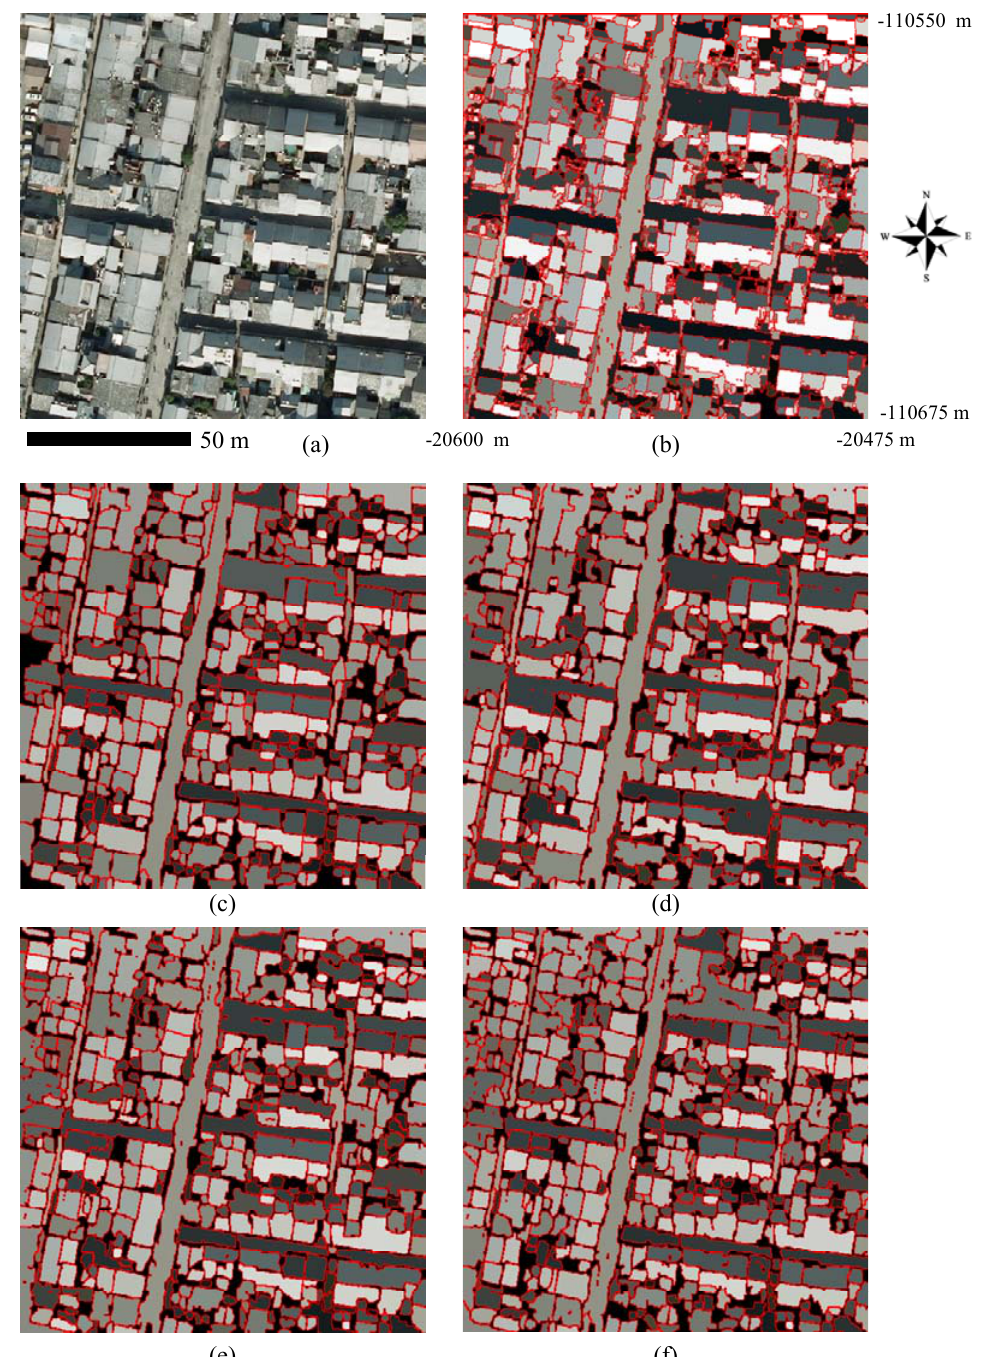
Figure 14. Segmentation results of upper left area of Figure 12a. ( a ) Aerial photograph; ( b ) segmentation result using ENVI EX 4.8; ( c ) segmentation result using the algorithm [18], merged with results with  d = 40; ( e ) segmentation result with  d  d i Parameter values of “Scale Level” and “Merge Level” in ENVI EX were set to 50 and 80,